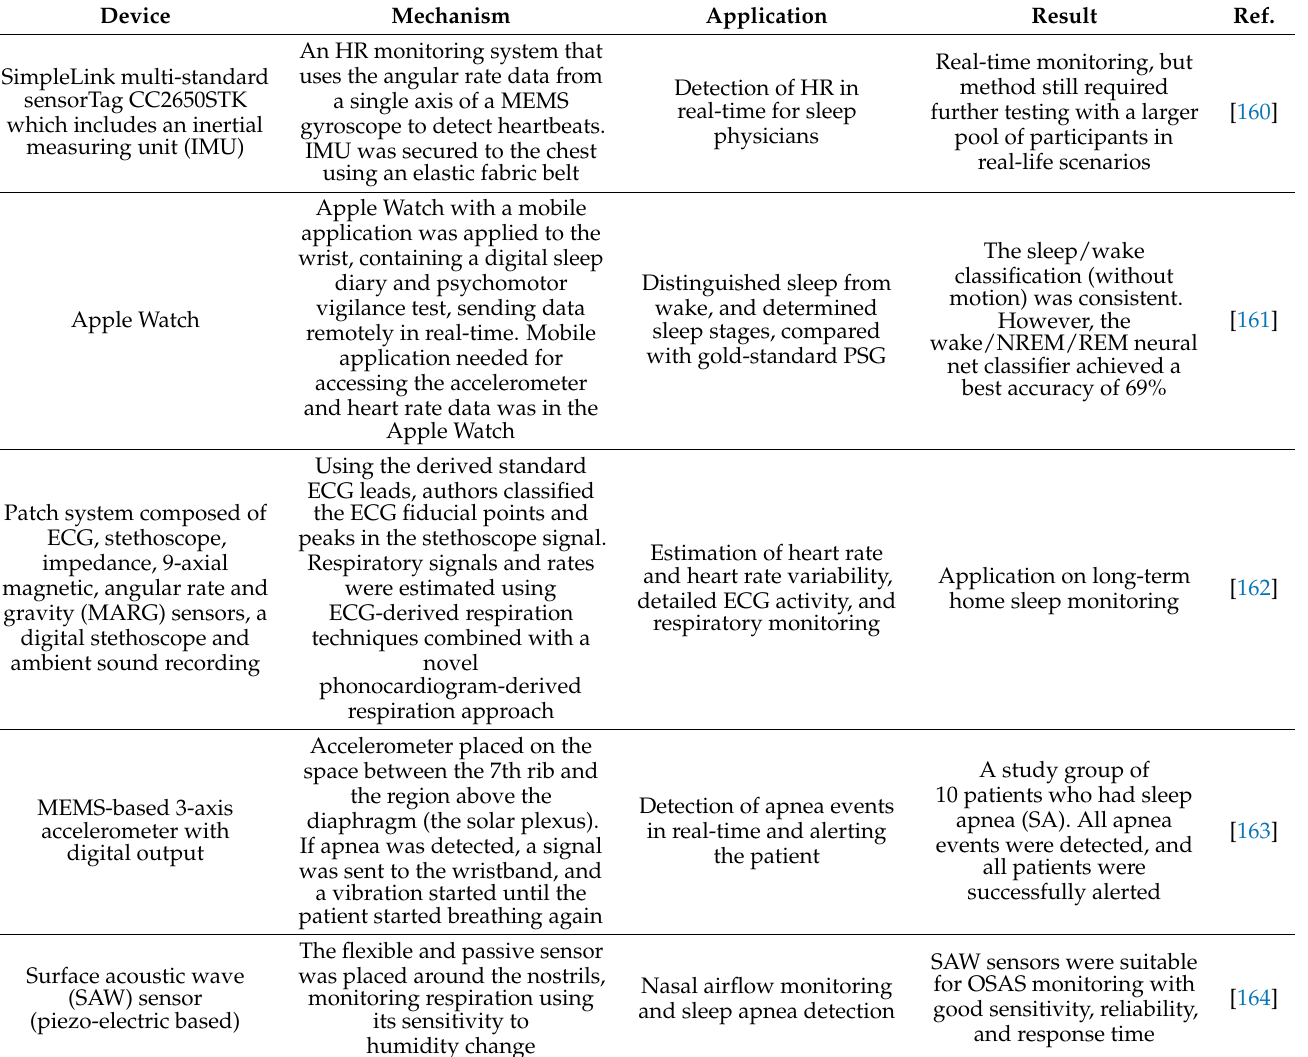
Table 6. Wearable devices for sleep monitoring and detection of